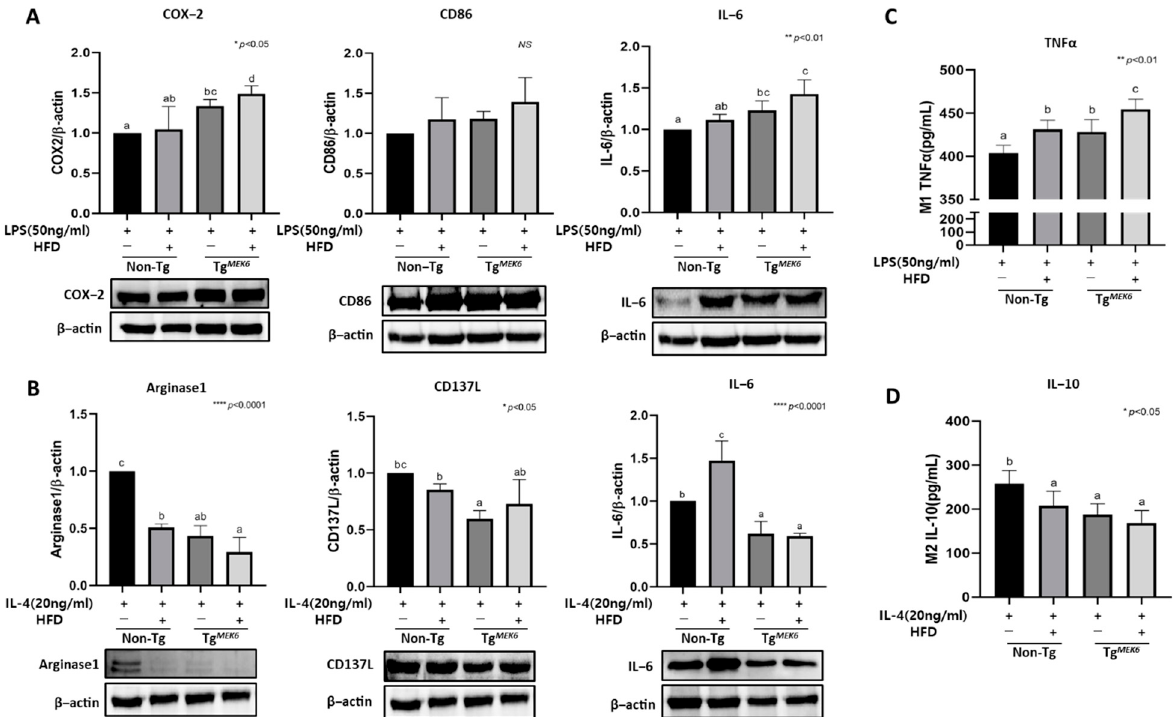
Figure 7. Effects of MEK6 on inflammatory cytokines of macrophage in BMDM. ( A ) The LPS (50 ng/mL)-induced M1 macrophage confirmed expression of proteins related to pro-inflammatory (COX-2, CD86, IL-6) by western blot. ( B ) The IL-4 (20 ng/mL)-induced M2 macrophage confirmed expression of proteins related to anti-inflammatory (Arginase-1, CD137L, IL-6) by western blot. ( C , D ) Cytokine levels of M1 and M2 culture supernatant such as IL-10 (anti-inflammatory) and TNF- α (pro-inflammatory) were measured by ELISA. Results are expressed as mean ± SD. Data were assessed by one-way ANOVA with Duncan’s test (NS, not significant by unpaired t -test. *; p < 0.05, **; p < 0.01, ****; p < 0.0001). Superscript letters (a–d) indicate the significant differences between the groups at p < 0.05. +, treatment or transfection; − , non-treatment or non ‐ transfection.